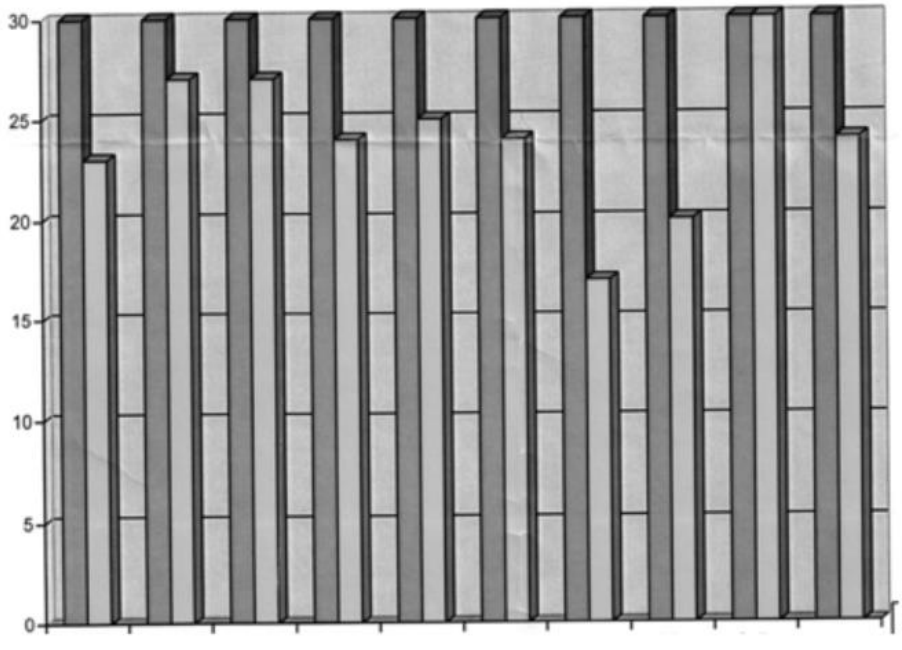
Figure 4. Battelle test graph. Table 2. Age equivalence by area.